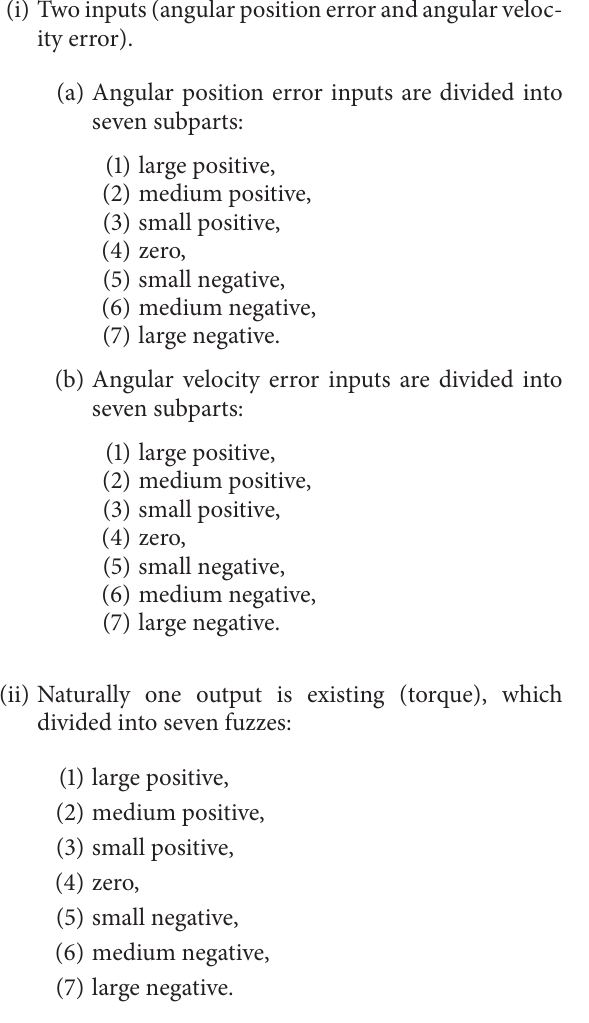
Figure 4: Angular position error membership functions.